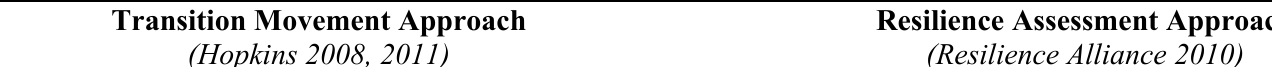
Table A1.1. Results from the qualitative text